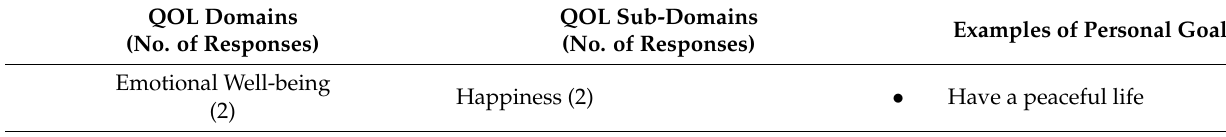
Table 4. Types of Personal